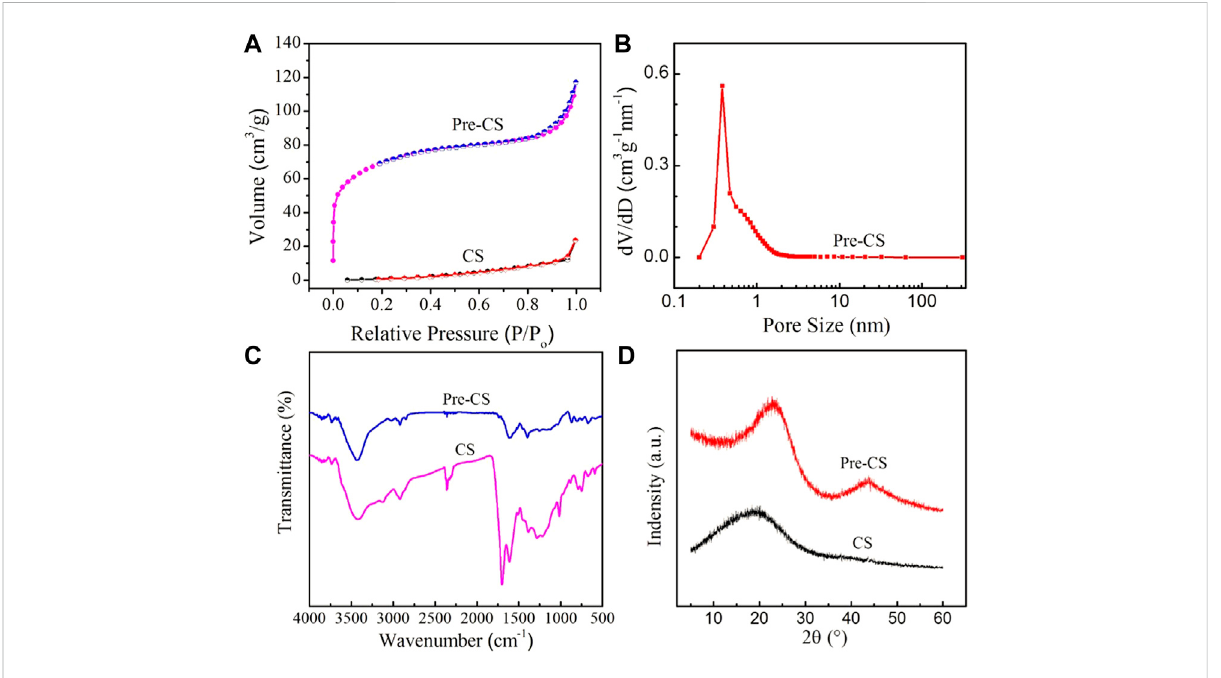
FIGURE 2 (A) Nitrogen adsorption-desorptionisotherm ofPre-CSs and CSs. (B) Pore size distributionofPre-CSs. (C) FTIRspectra ofPre-CSs and CSs. (D) XRD patterns of Pre-CSs and